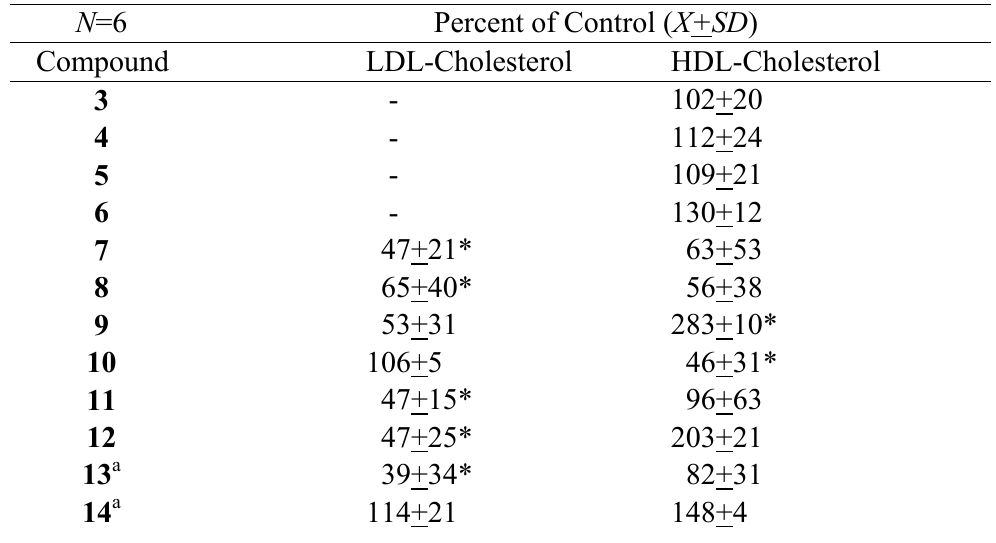
Table 5: In Vivo Hypolipidemic Activity of the substituted pyrroles ( 3-15 ) in CF-1 male mice at 8mg/kg/day, IP for 14